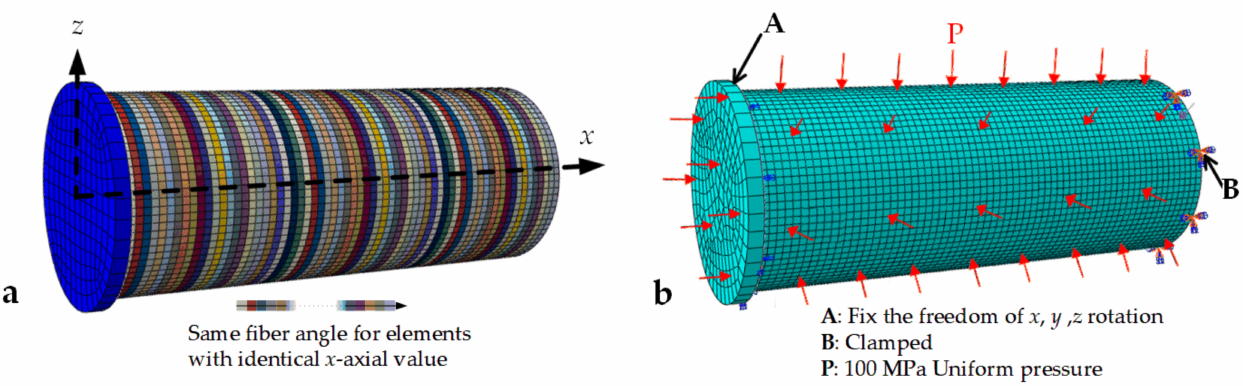
Figure 5. The DFE simulation model: ( a ) fiber angle distribution based on Shift Method and ( b ) boundary condition.